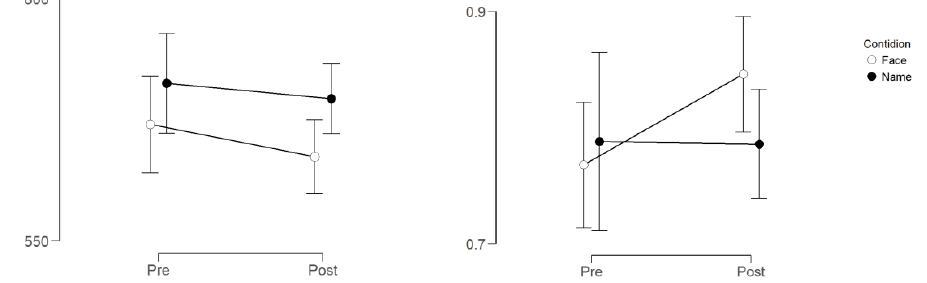
Figure 2. Di ff erences PRE versus POST moments for the target stimuli on the face and name recognition Mathematics 2020 , 8 , x FOR PEER REVIEW Figure 2. Differences PRE versus POST moments for the target stimuli on the face and name conditions. On the left, di ff erences on latencies. On the right, di ff erences on accuracy. recognition conditions. On the left, differences on latencies. On the right, differences on accuracy.